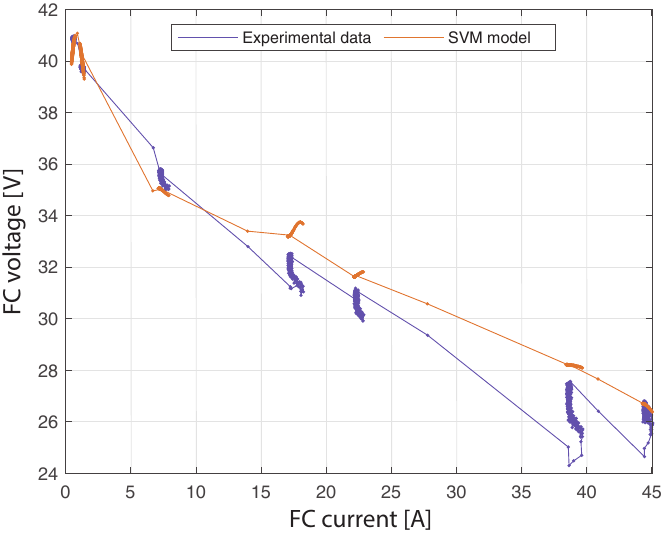
Figure 7. Dynamic V-I characteristic of the PEMFC obtained with real and estimated FC voltage using the SVM model, from the first profile of the FC load current.